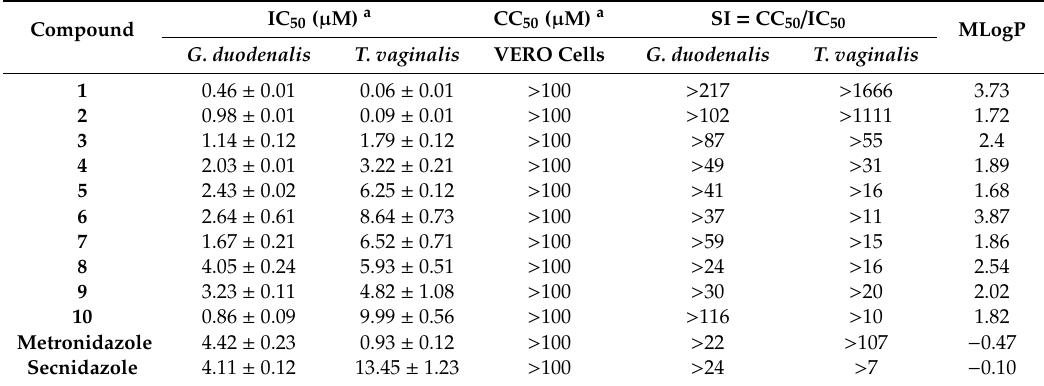
Table 1. In vitro antiprotozoal and cytotoxic effects of carbamates 1 – 10 on Giardia duodenalis and Trichomonas vaginalis.